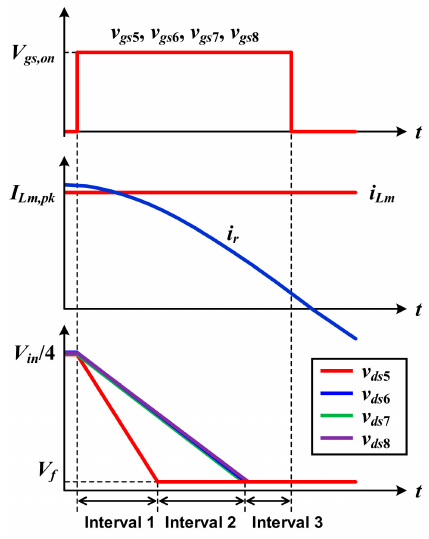
Figure 5. Turn-on switching transient